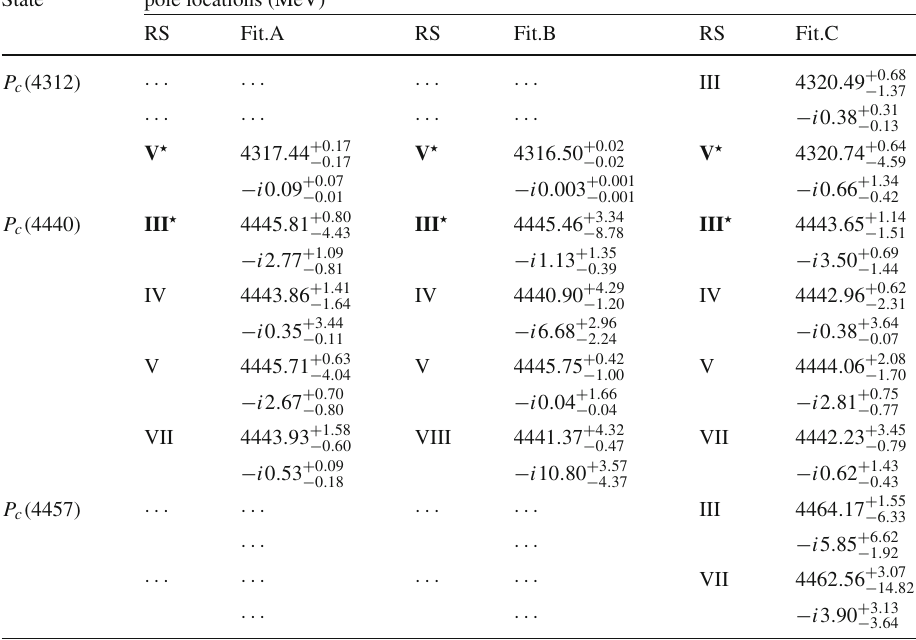
Table 5 The pole locations and residues given by our fits. The Riemann sheets with bold type and the ‘ (cid:13) ’ symbol means that they are close to the physical sheet. For each pole the locations of all the fits on these sheets have difference at the order of 0.1-1